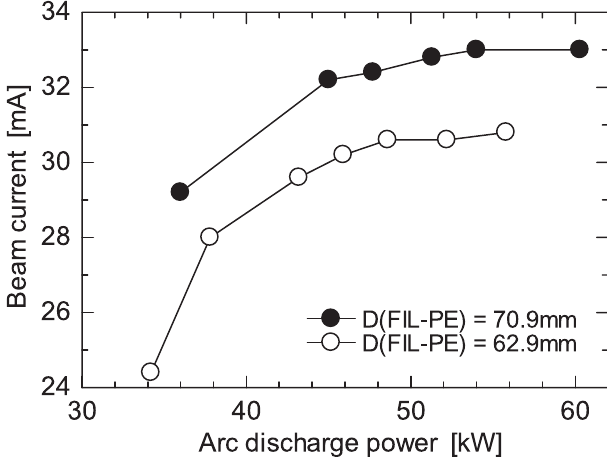
FIG. 5. Dependence of beam current on arc discharge power for different filament positions.